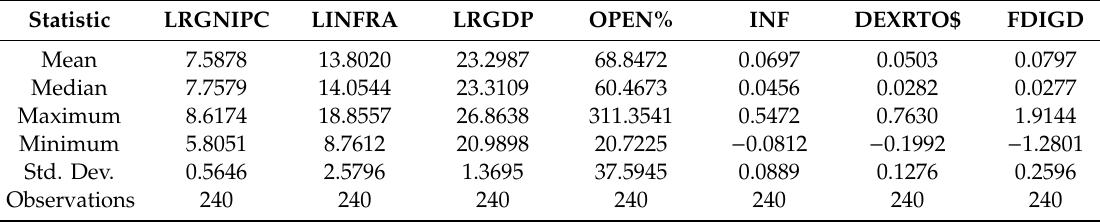
Table 3. Mean and standard deviation of the variables. Source: Authors’ work.